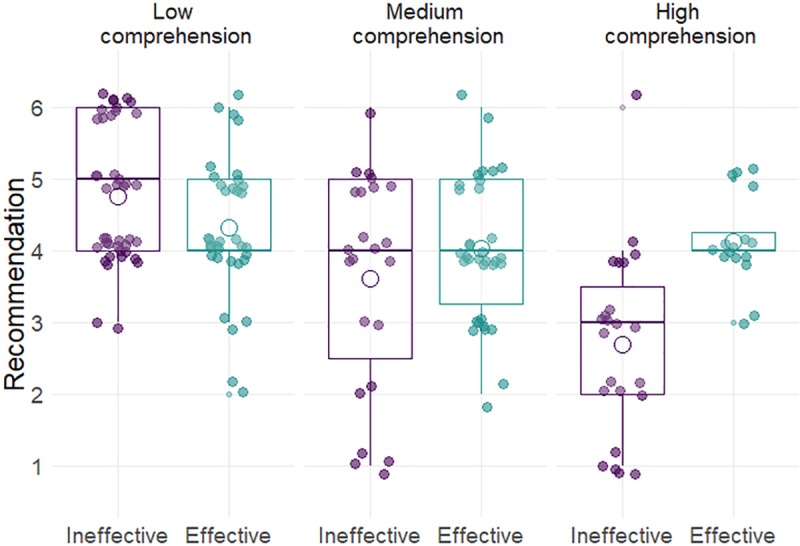
Effect of the screening effectiveness manipulations on recommendations as a function of comprehension.Illustration is based on terciles: low, medium, and high.